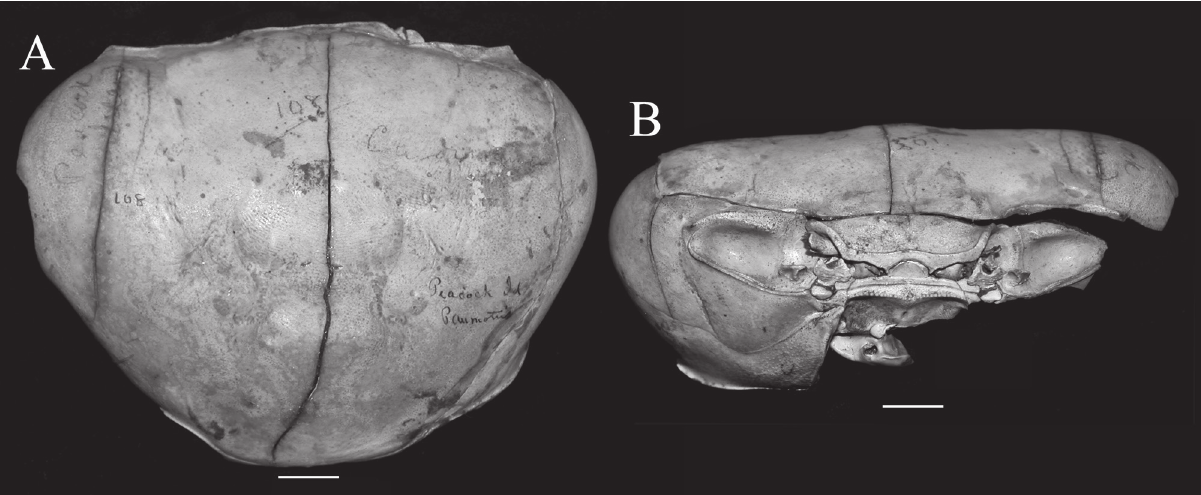
Figure 5. Cardisoma obesum Dana, 1851, lectotype male (90.6 × 70.0 mm) (USNM 2356). A, dorsal view of carapace; B, frontal view of cephalothorax. Scale bars = 10.0